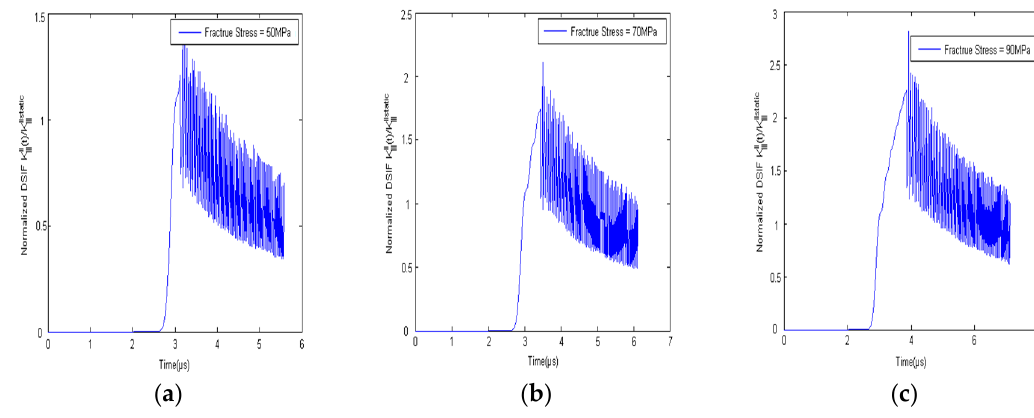
Figure 19. Normalized dynamic stress intensity factor versus time for σ fractrue = 50 Mpa ( a ); for σ fractrue = 70 Mpa ( b ); and for σ fractrue = 90 Mpa ( c ).